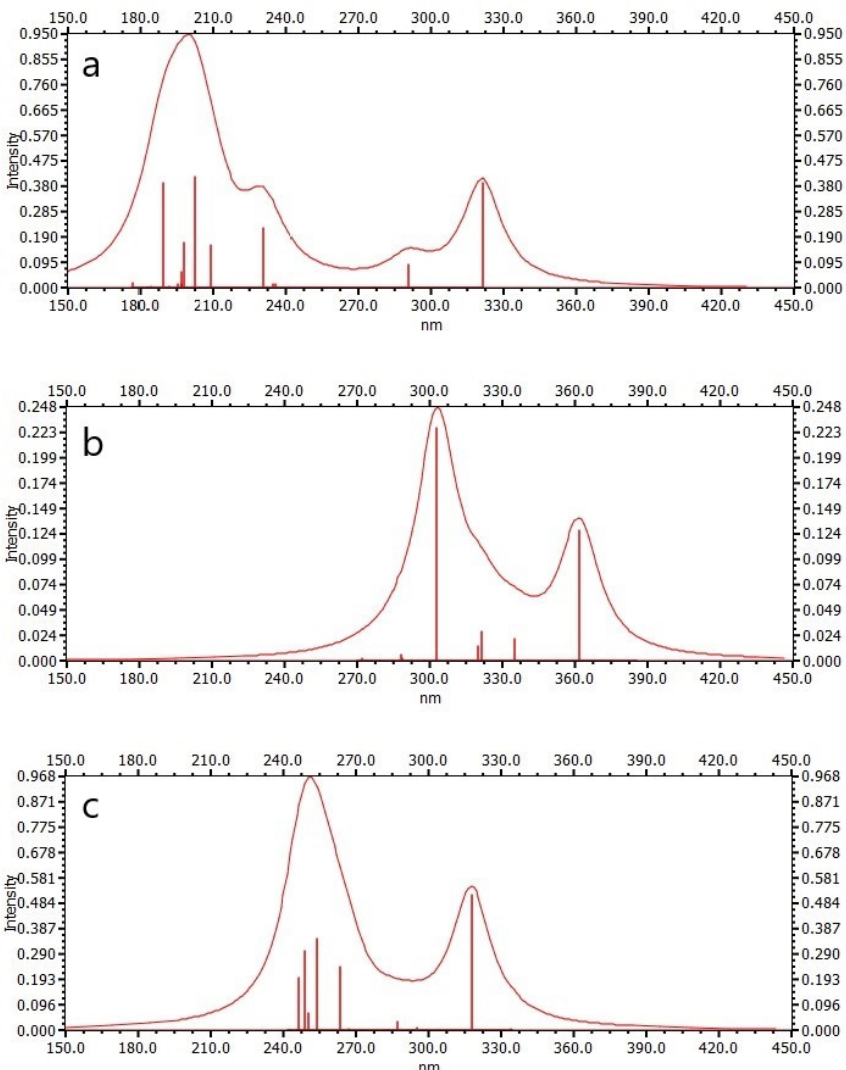
Figure 6. Electronic excitation spectra: ( a ) coumaphos ( Cou ), ( b ) AchE cluster model with coumaphos (AchE_1_ Cou ), and ( c ) BChE cluster model with coumaphos (BChE_1_ Cou ).